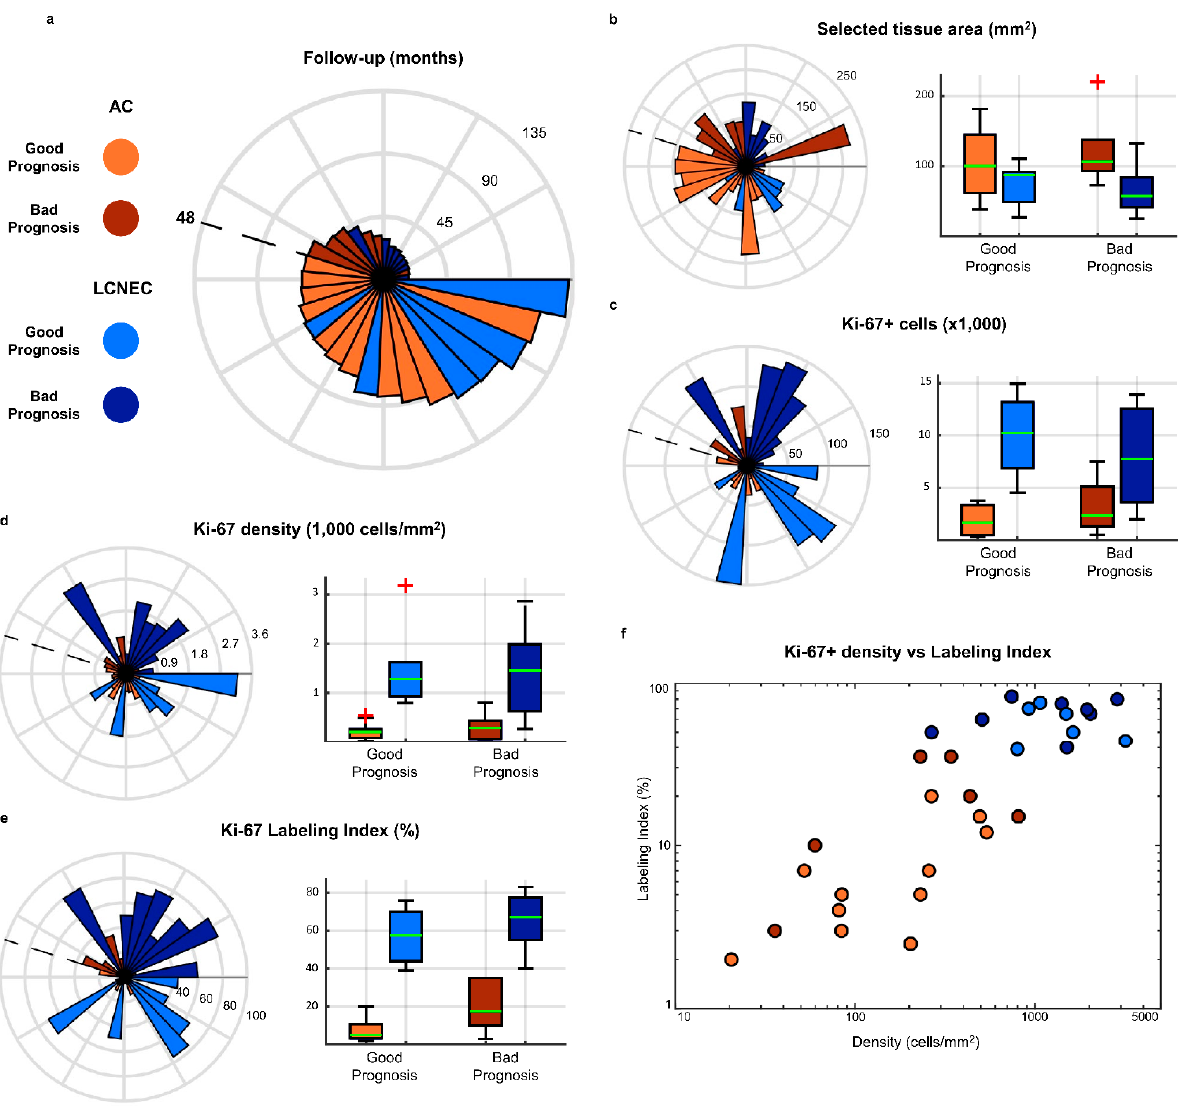
Figure 2. Dataset characteristics. ( a – e ) Radial plots of samples’ characteristics, each ordered as in ( a ), to allow comparison; ( b – e ) also include the corresponding bar plot, grouped by prognostic class and tumour type. ( a ) Follow-up intervals of patients in months, sorted increasingly counterclockwise. The dashed line represents the separation point between poor prognosis and good prognosis samples, at 48 months. ( b ) Overall outlined area of the WSI after the outlining procedure, i.e., total area on which the identification of Ki-67-positive cells was then performed. ( c ) Number of identified Ki-67 + cells. ( d ) Density of Ki-67 + cells computed over the entire outlined area. ( e ) Ki-67 Labelling Index, i.e., the manually evaluated percentage of Ki-67 + cells over the total number of cells in an area of ≥ 2 mm 2 , or, equivalently, over at least 2000 cells. ( f ) Relationship between Ki-67 + cell’s density and Ki-67 Labelling Index, each presented in logarithmic scale. Correlation analysis between the two yielded r = 0.51 and p =